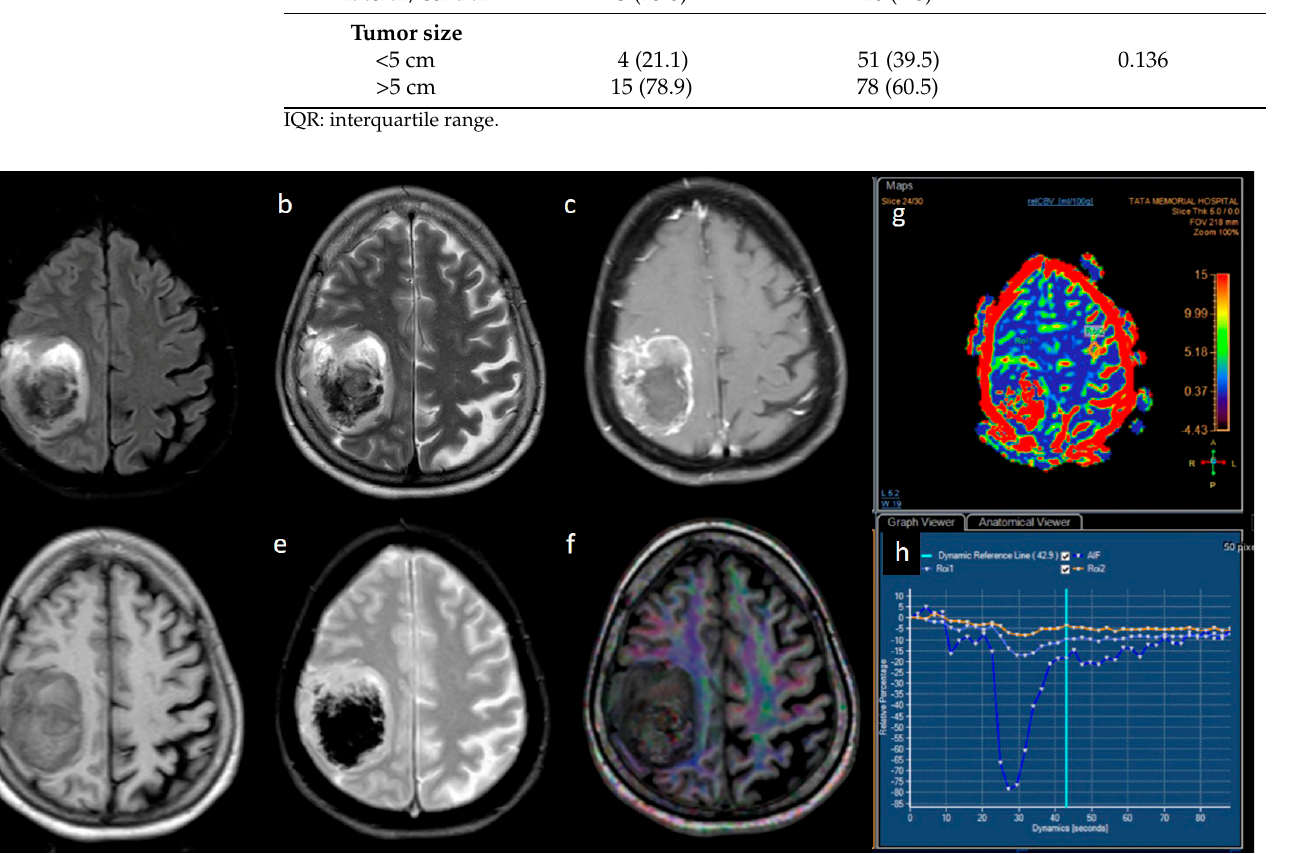
Figure 2. ( a − h ) FLAIR, T2, T1, post-contrast T1, GRE, DTI, perfusion color map, and graph representing an IDH-wildtype glioblastoma. Images a–e reveal a heterogeneous peripheral rim-enhancing right frontoparietal mass with significant internal necrosis and hemorrhage. Image f is a DTI image that shows subcortical and adjacent parenchymal infiltration. Images g and h reveal significant